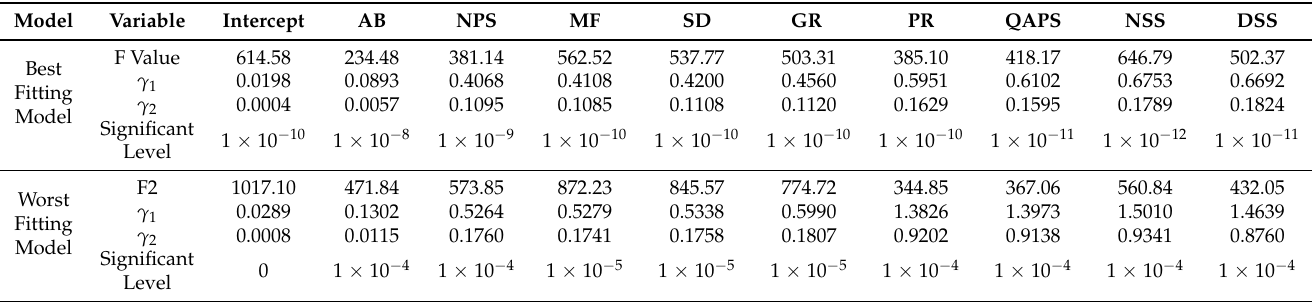
Table A5. F2 Hypothesis